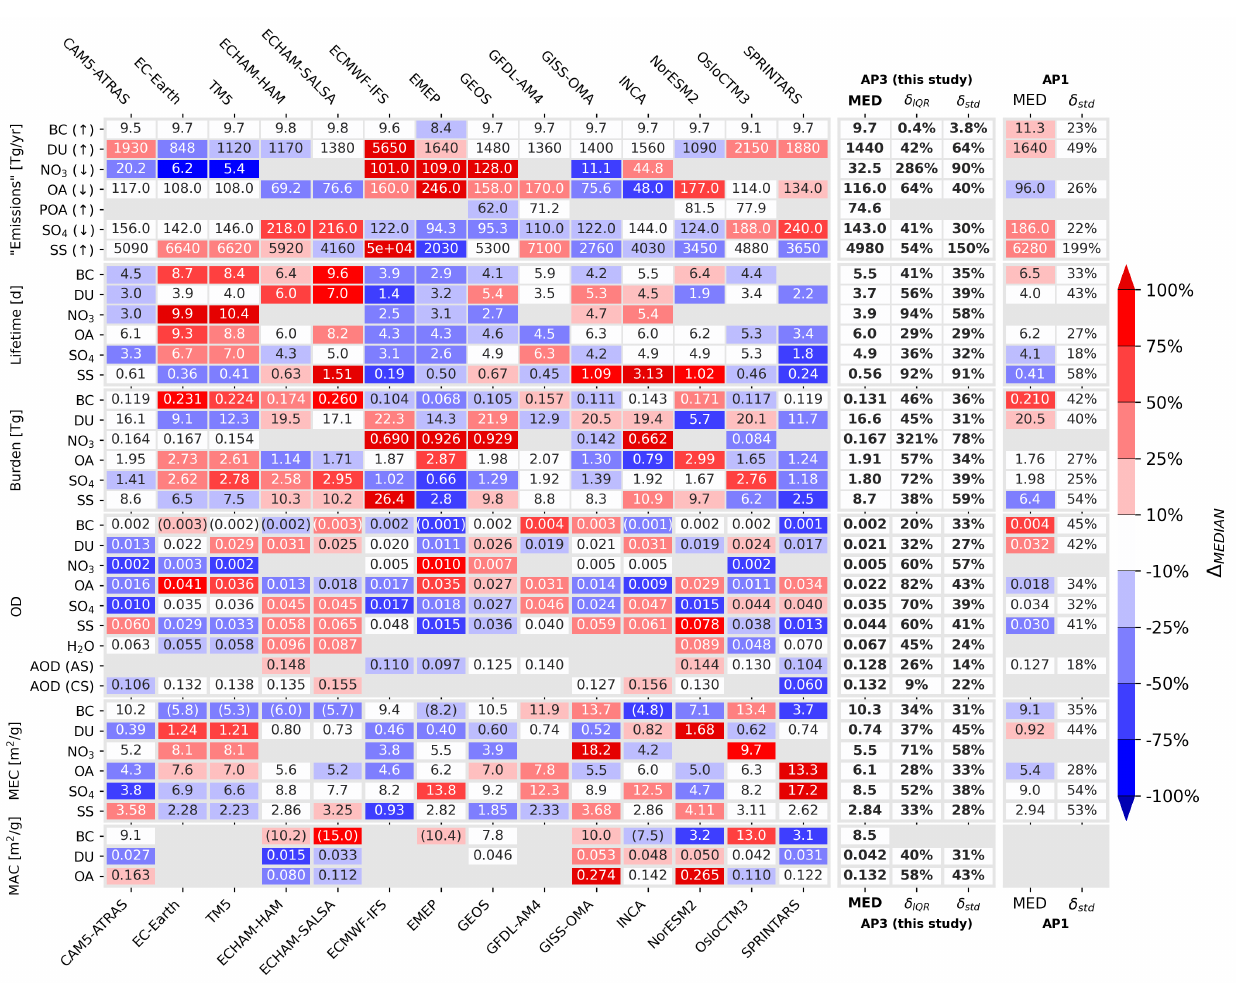
Table 3. Global annual averages for each aerosol species, grouped by aerosol emissions, lifetimes, burdens, optical depths (ODs), mass extinction coefficients (MECs), and mass absorption coefficients (MACs), for models participating in the AP3-CTRL experiment, in the year 2010. Also shown in the OD section are total AOD for all-sky (AOD (AS)) and clear-sky (AOD (CS)) conditions as well as AOD due to water (H 2 O). The following columns show the median from all model values (MED) and associated diversities as interquartile range and standard deviation ( δ IQR , δ std ). AP1 median and standard deviation are based on values given in Table 10 in Textor et al. (2006) and Table 4 in Kinne et al. (2006). Colours illustrate the bias of individual model and AP1 median values with respect to the AP3 median. Units of emissions and burdens are full molecular weight (for OA and POA, the total organic weight is used). Note that the “emissions” of SO 4 , NO 3 , and OA are really secondary chemical formation in the atmosphere plus primary particle emissions. They are computed using total deposition as a proxy (indicated with ↓ ). For BC ↑ , DU ↑ , POA ↑ , and SS ↑ the provided emission data were used. For OsloCTM3 an additional OD of 0.0086 due to biomass burning was reported and is not included here. See further details on parameter computation in Sect. 2.2. Values in brackets indicate erroneous or inconsistent values (i.e. BC OD, MEC, and MAC from some models) and are not included in the corresponding AP3 median value (MED) and diversities (details are discussed in Sect.